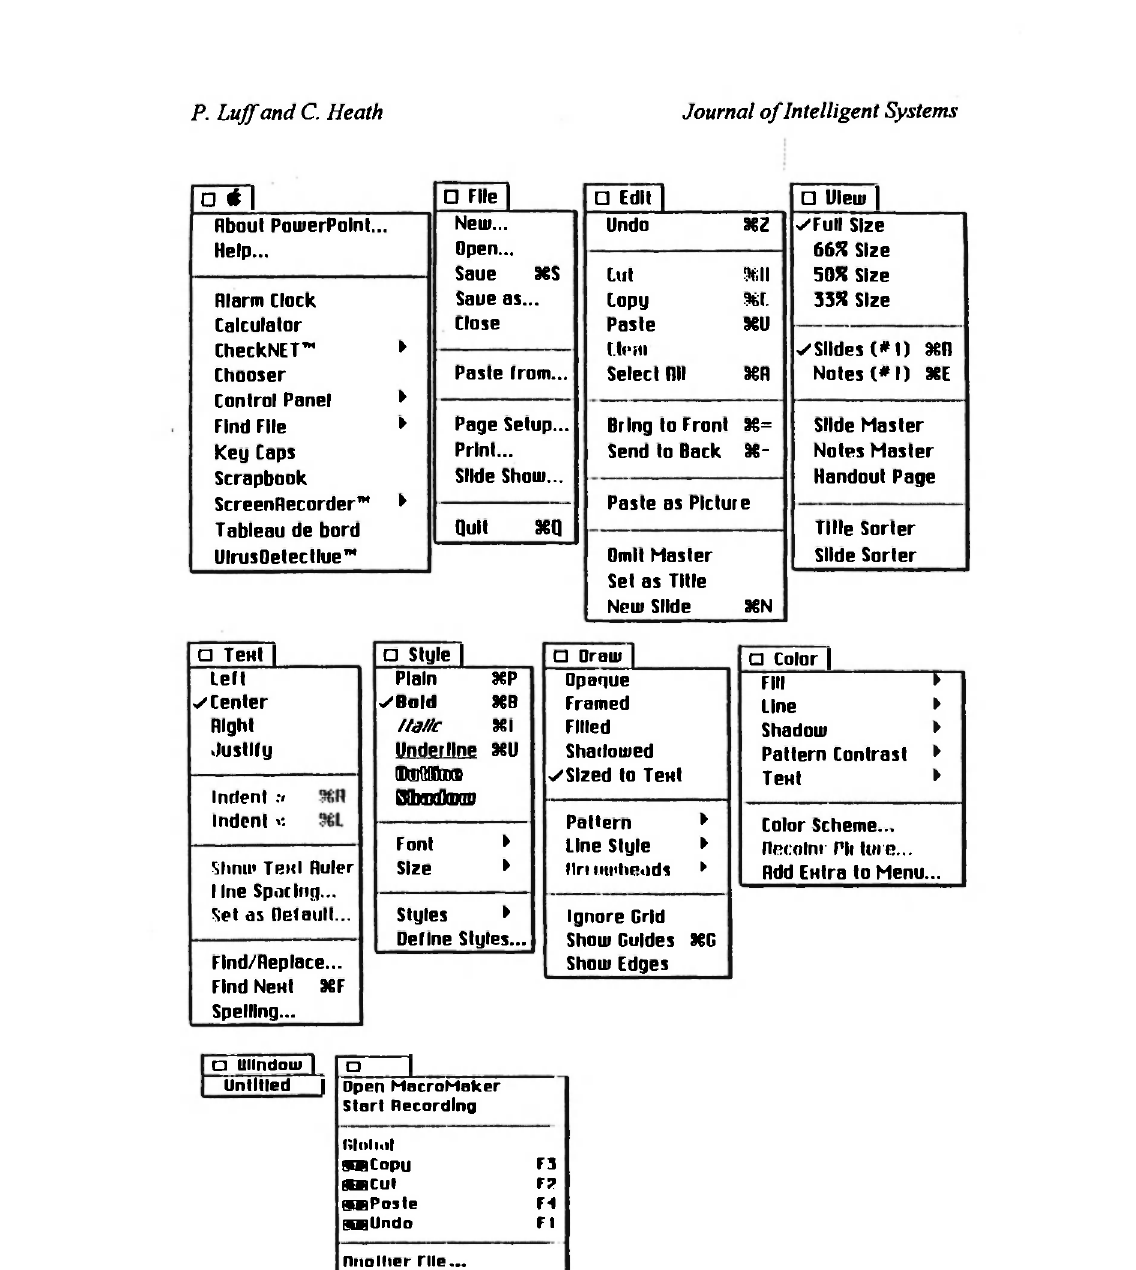
Fig. 2: The PowerPoint